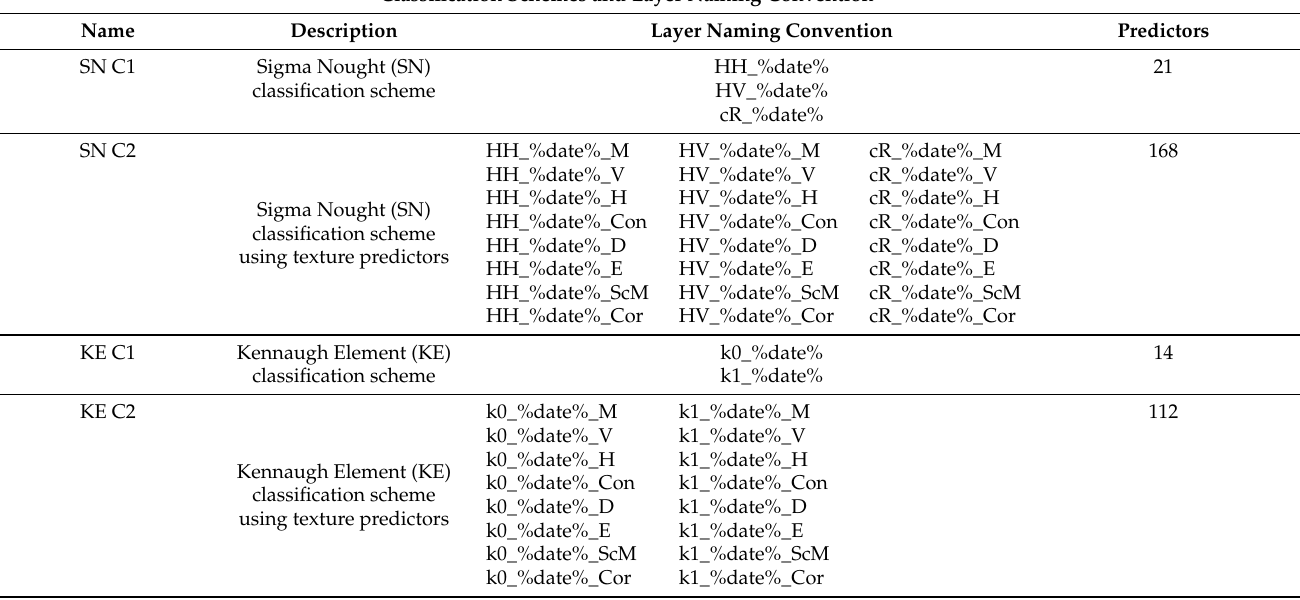
Table 4. The Random Forest classification schemes with the layer naming convention for the predictor variables and the total number of predictors. The term %date% stands for the TerraSAR-X acquisitions: jul27, aug18, sep09, oct01, oct23, nov14, dec06. Classification Schemes and Layer Naming